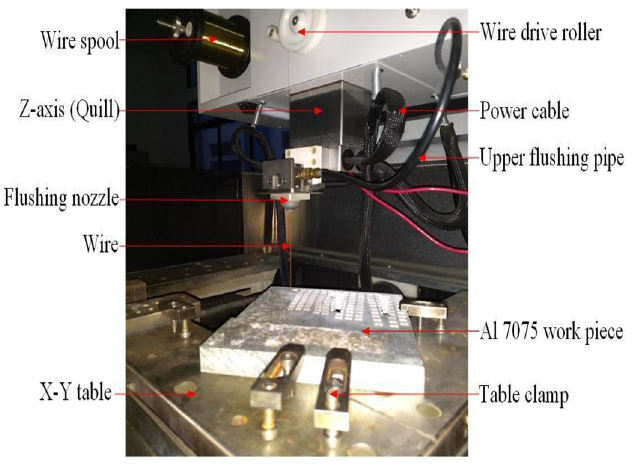
Fig. 1. Pictorial view of WEDM table unit (Model: EX 40).